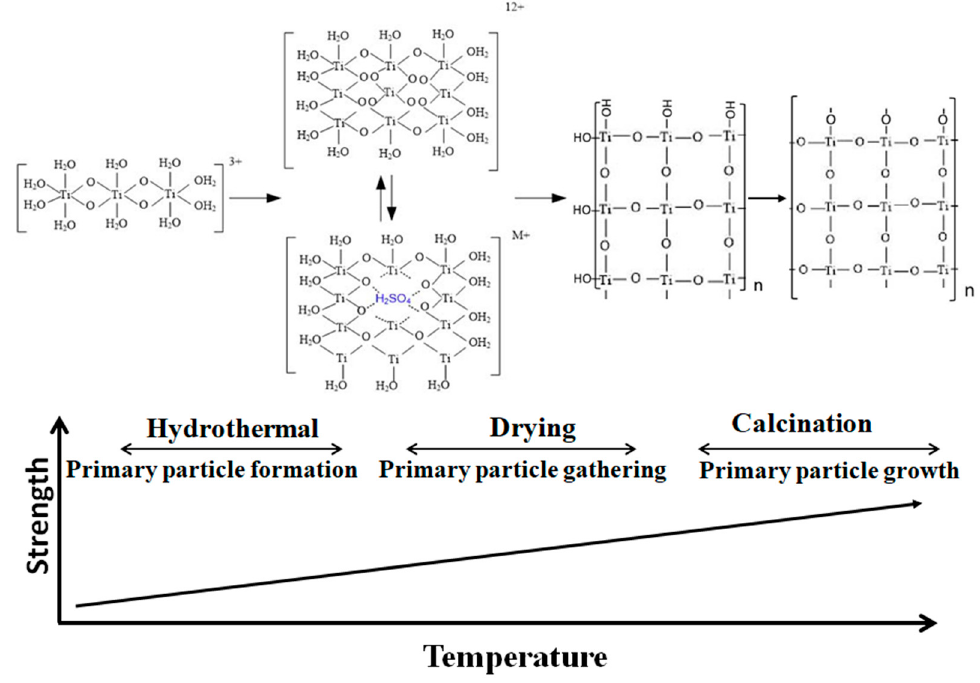
Figure 8. The proposed structure and strength evolution of the filter cake with the increase of temperature.